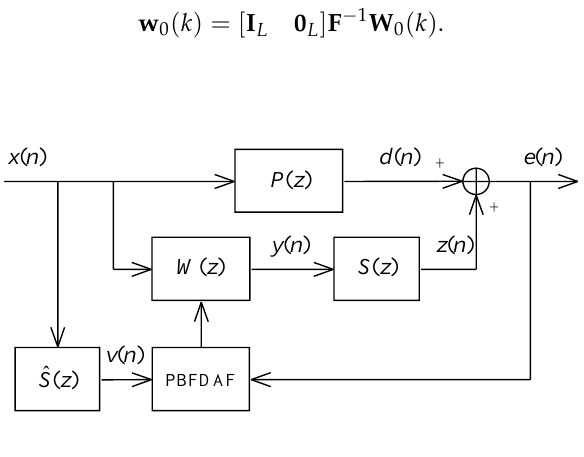
Figure 4. Qiu’s delayless algorithm.